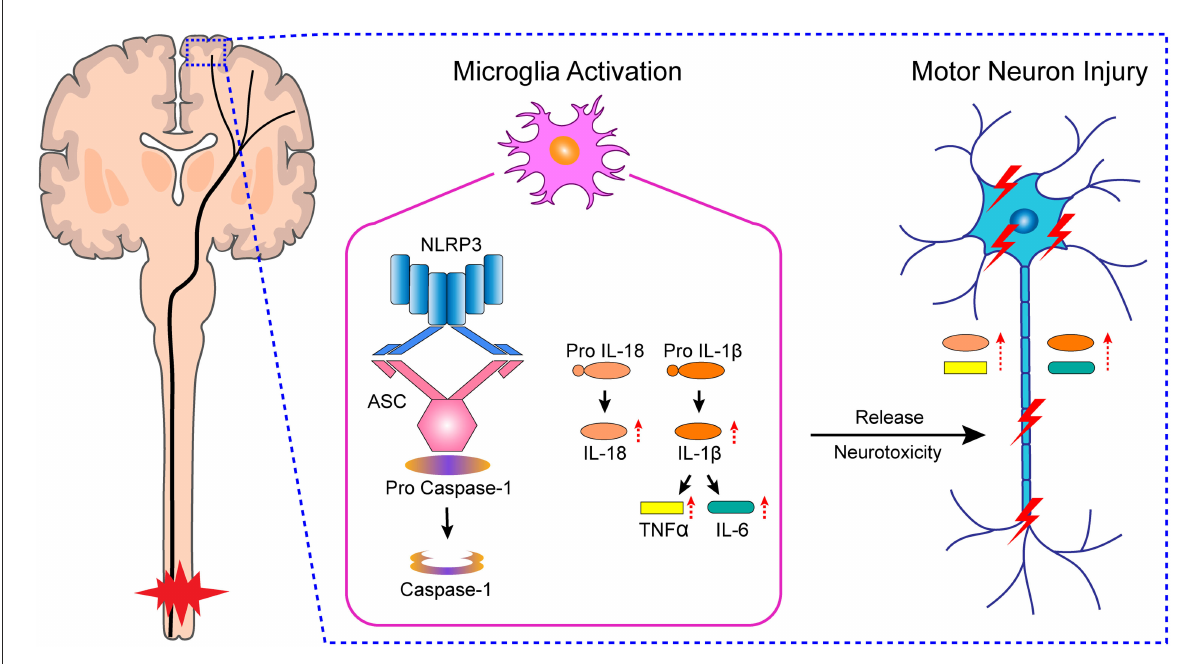
FIGURE7 Hypothetical mechanism of neuronal damage in M1 of SCI